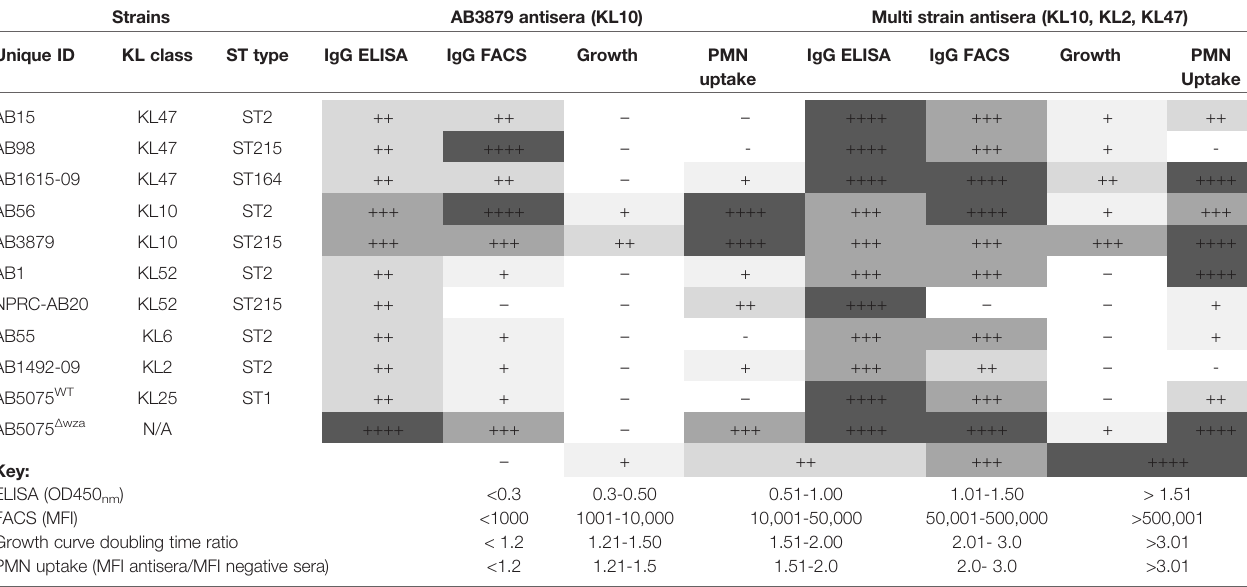
TABLE 3 | Summary of the in vitro assays measuring AB3879 and multi strain antisera effect on A. baumannii strains. Strains AB3879 antisera (KL10)